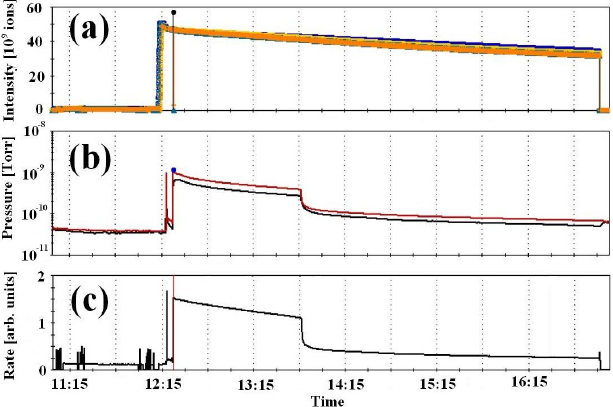
FIG. 4. (Color) Pressure rise in the PHOBOS experimental area after rebucketing with 56 bunches. The beam intensities in the Blue and Yellow ring (a) slowly decay during a store, and the pressure measured in 2 gauges (b) drops sharply after some time. With high pressure the experimental background (c) is increased